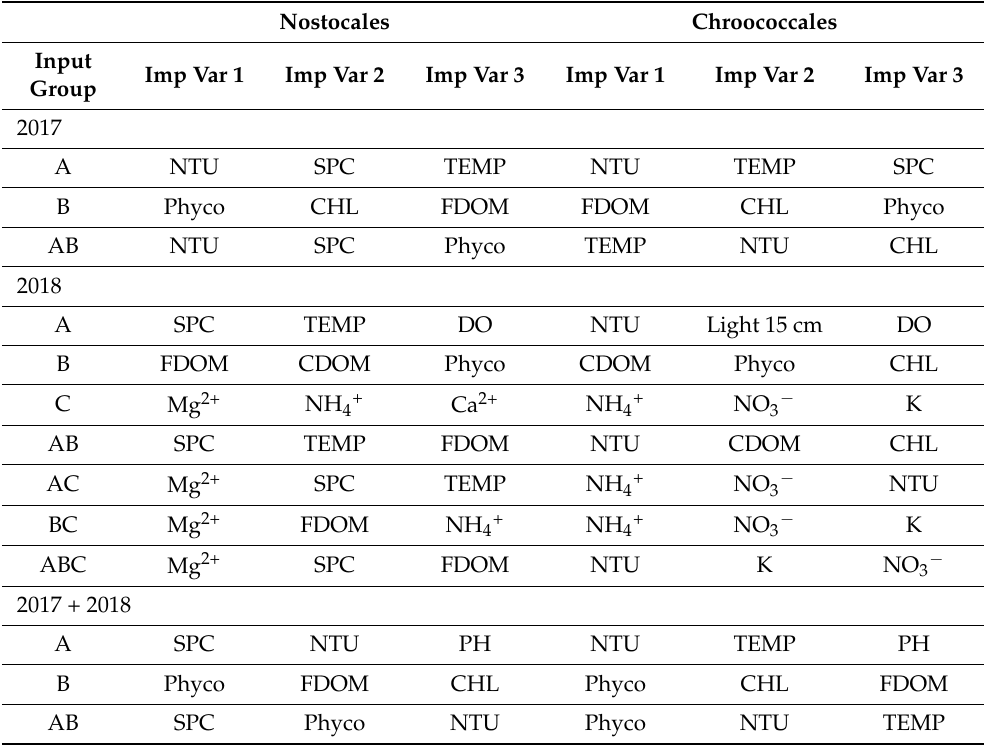
Table 6. Most influential predictors for cyanobacteria orders, Nostocales and Chroococcales, in Pond 2 as determined using the random forest